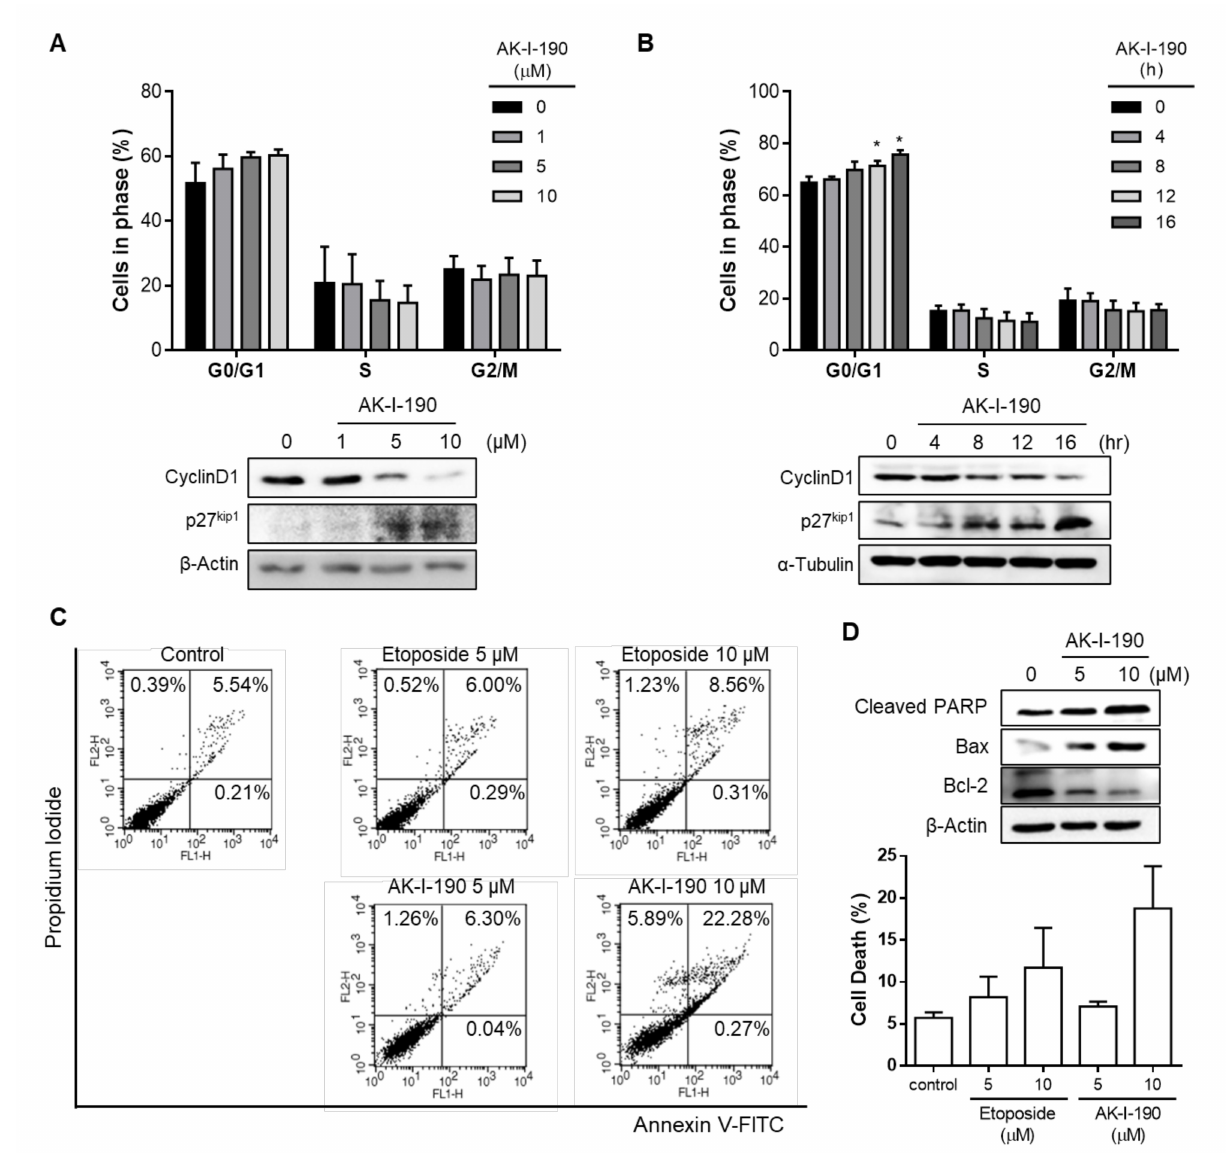
Figure 4. Apoptosis induced by AK-I-190. ( A , B ) Cell cycle analysis of AK-I-190-treated DU145 cells. G1 arrest was observed in AK-I-190 concentration- ( A ) and time-dependent ( B ) manners. * p < 0.05 vs. Western blot analysis of G1 checkpoint markers, cyclin D1 and p27 kip1 , in DU145 cells after treatment of AK-I-190. ( C ) Apoptosis induction assessed using Annexin V–PI double staining. DU145 cells were treated with varying concentrations of AK-I-191 for 36 h. Apoptotic cells were detected by flow cytometry and plotted as Annexin V-positive cells on the right side. ( D ) Evaluation of apoptosis at the protein expression level. Protein levels of pro- and anti-apoptotic proteins bcl-2, bax, and cleaved PARP were analyzed using Western